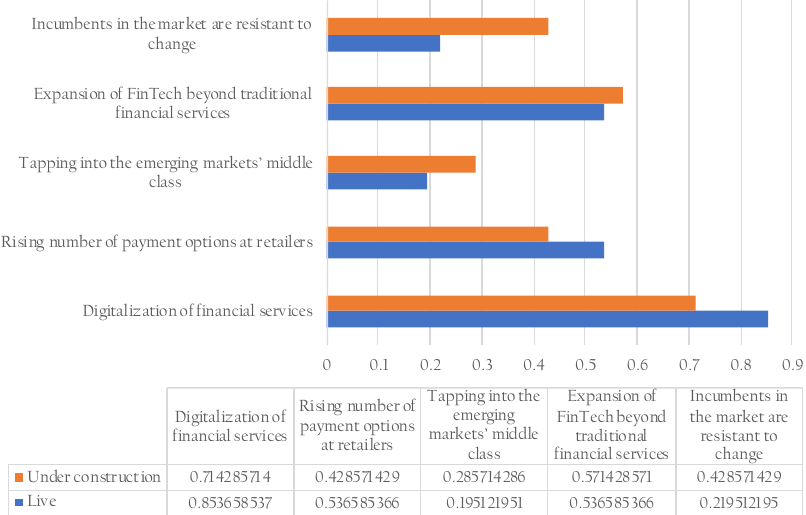
Figure 8. Triggers behind FinTech development—distribution of answers across the maturity of the